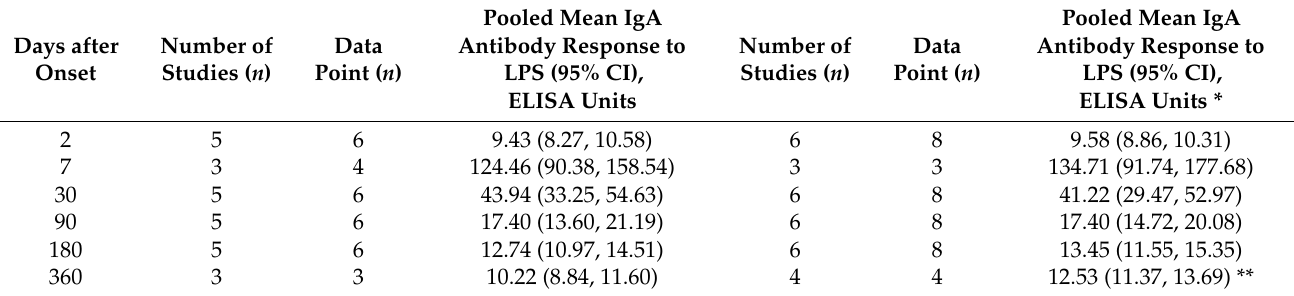
(B) Figure 4. ( A ) Forest plots of the kinetics of anti-lipopolysaccharide IgA following cholera [37–40,42]. ( B ) Kinetics of anti-lipopolysaccharide IgA following cholera. Table 4. Kinetics of anti-lipopolysaccharide IgA following